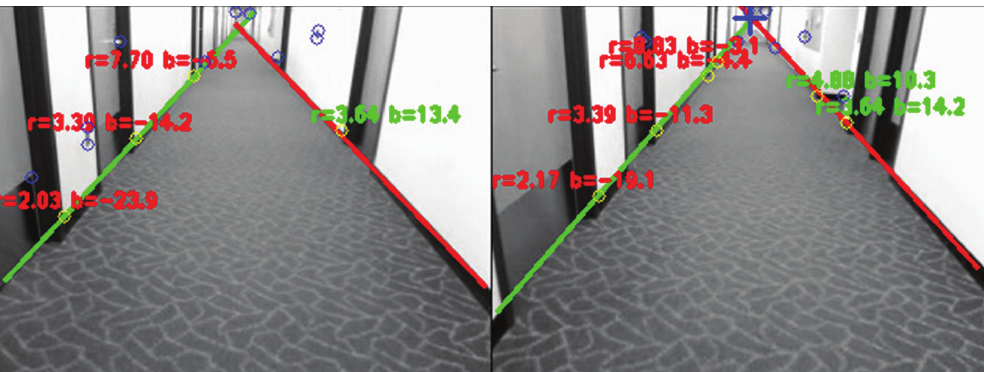
Figure 5: On-the-fly range measurements. Note the crosshair indicating the algorithm is currently using the infinity point for heading.